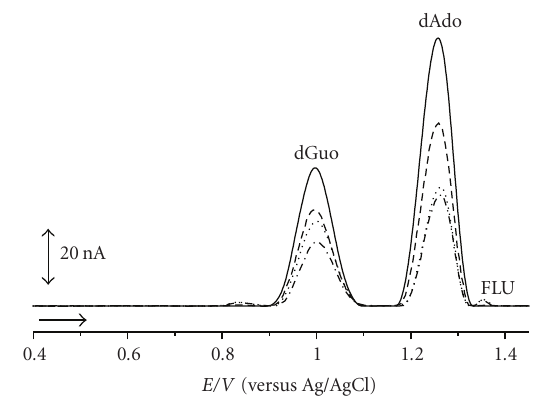
Figure 6: DP voltammograms baseline corrected in pH 4.5 0.1 M acetate bu ff er with dsDNA-electrochemical biosensors (solid line) before and after incubation during (dashed line) 5min, (dotted line) 10min, and (dash dotted line) 15min in a solution of 50 μ M FLU. Pulse amplitude-50 mV, pulse width-70ms, and scan rate ν = 5mVs − 1